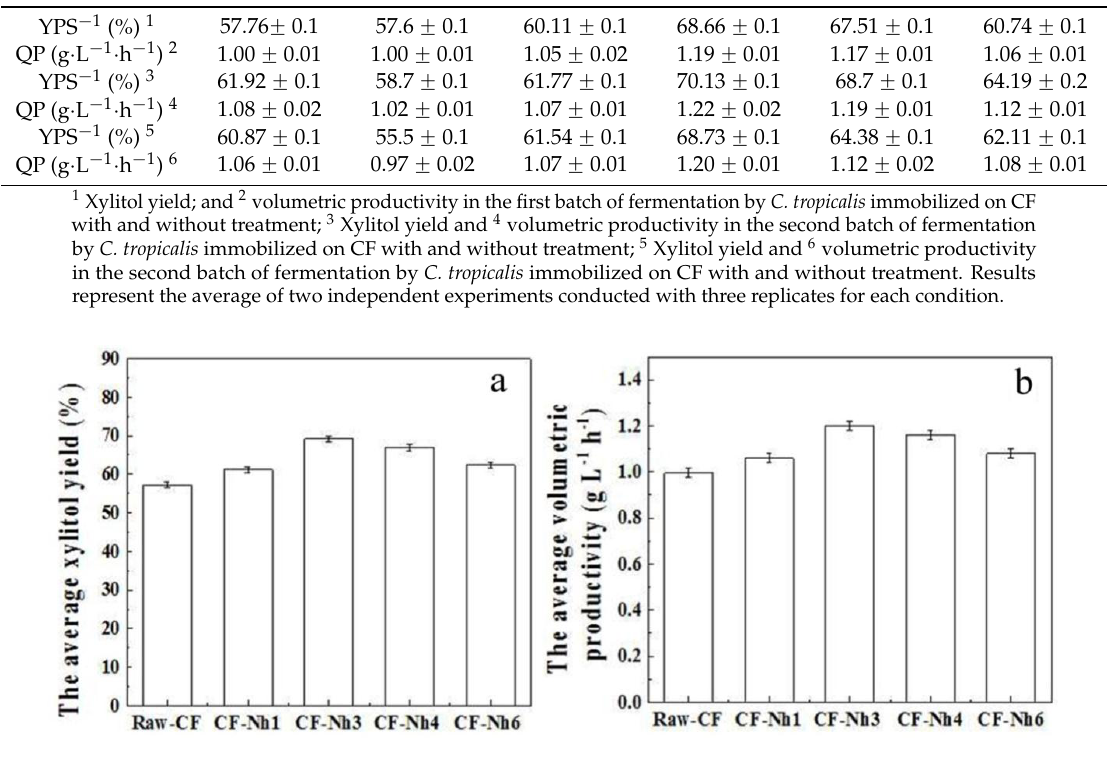
Figure 5. Effect of oxidation time on the multi-batch xylitol fermentation ( a ) Effects of oxidation time on the average xylitol yield of fermentation batches; ( b ) Effect of oxidation time on the average volumetric productivity of the fermentation batches.